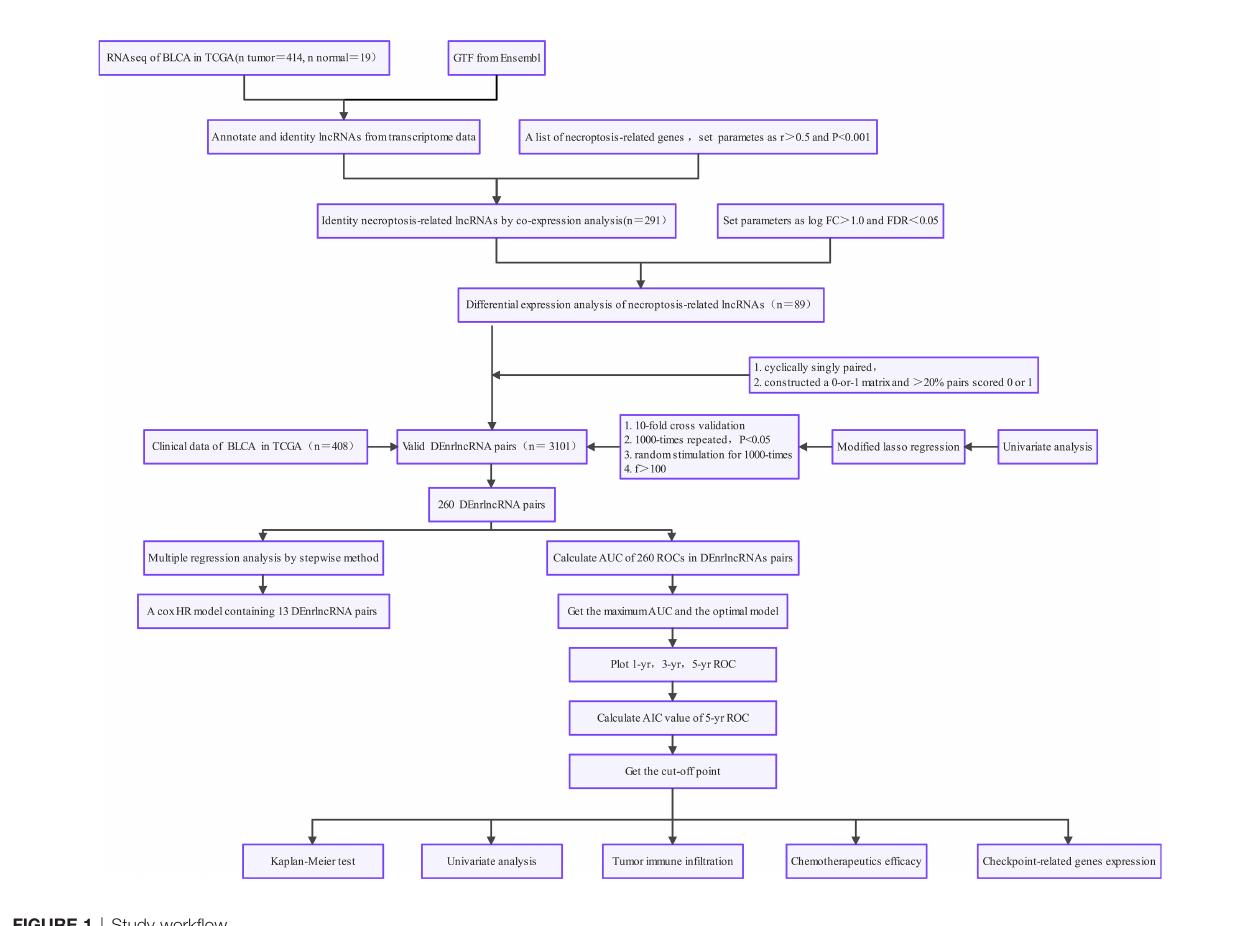
FIGURE 1 | Study work fl